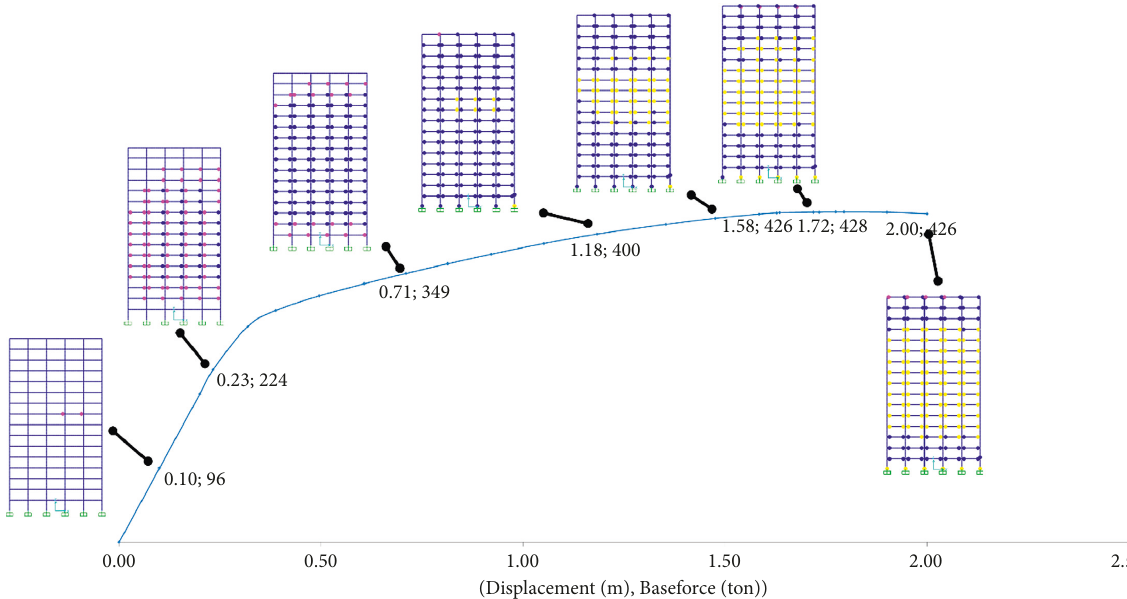
Figure 18: Push diagram of the 16-story frame designed by the energy